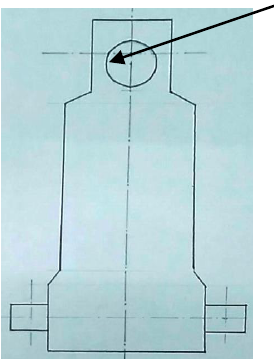
Figure 5. Bottom case with shifted axle hole